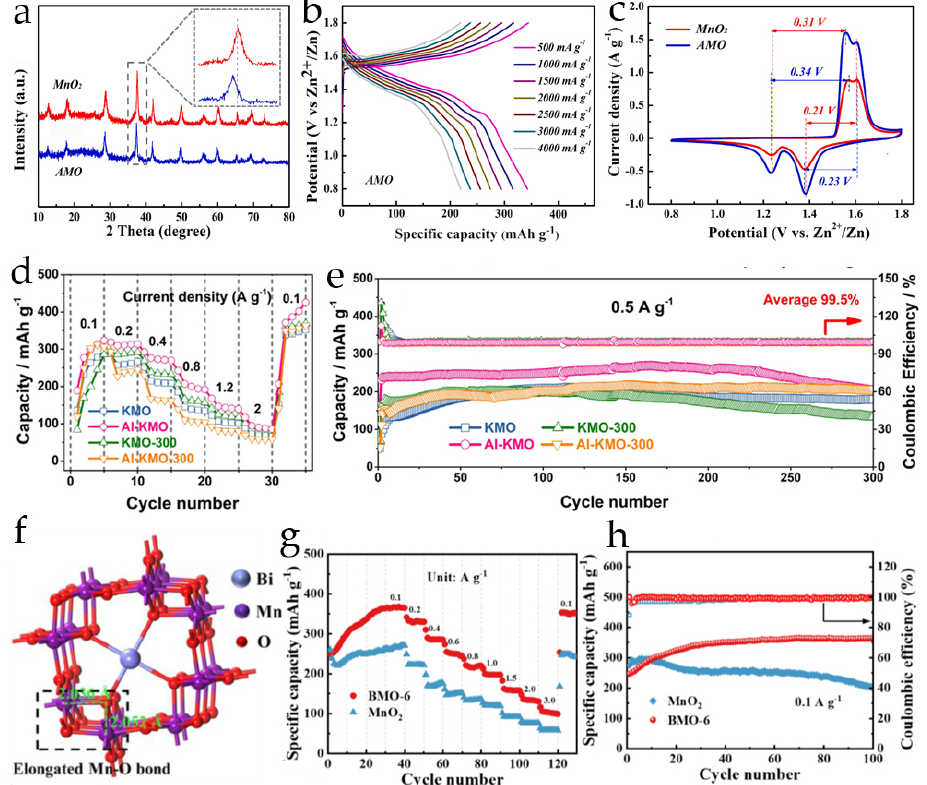
Figure 8. ( a ) XRD patterns of MnO 2 and AMO [24]; ( b ) GCD profiles of AMO cathode under different current densities [24]. ( c ) Cyclic voltammograms of MnO 2 and AMO cathodes at scan rate 0.2 mV·s − 1 [24]. ( d ) Rate performance of KMO, Al-KMO, KMO-300 and Al-KMO-300 [57]. ( e ) Cycling performance of KMO and Al-KMO materials [57]. ( f ) Schematic relaxed structure of Bi-doped MnO 2 [59]. ( g ) C-rate capability and ( h ) long-term cycle performance of pristine and Bi-doped MnO 2 cathodes [59].